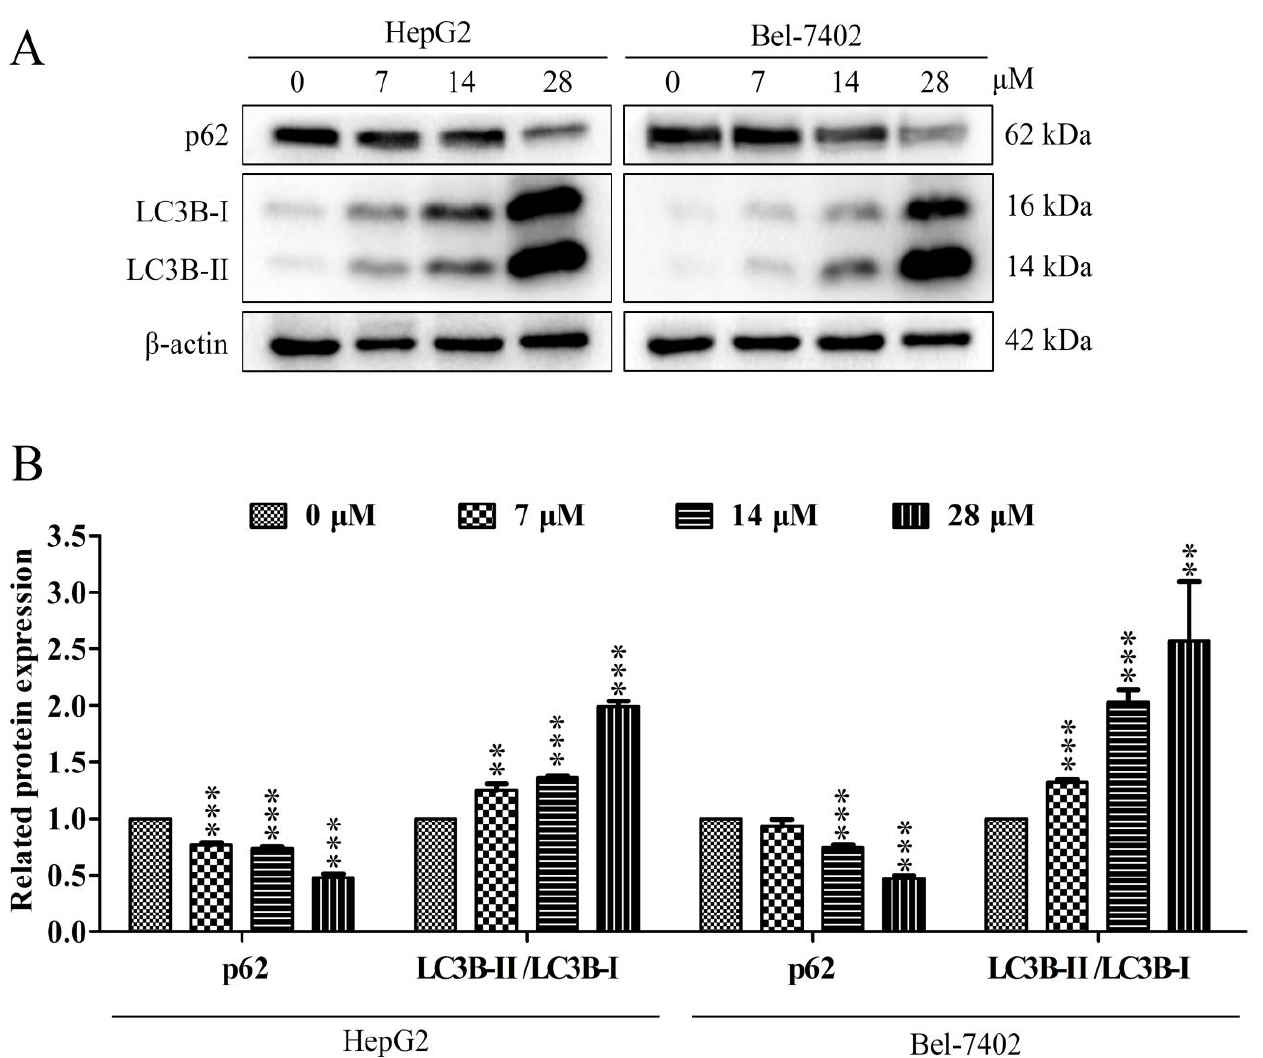
Figure 6. Effects of davidone C on the autophagy related proteins of liver cancer cells. ( A , B ) The related expressions of p62, LC3-I and LC3-II in HepG2 and Bel-7402 cells were detected by Western blotting. β -actin was used as a control (* p < 0.05, ** p < 0.01 or *** p < 0.001).